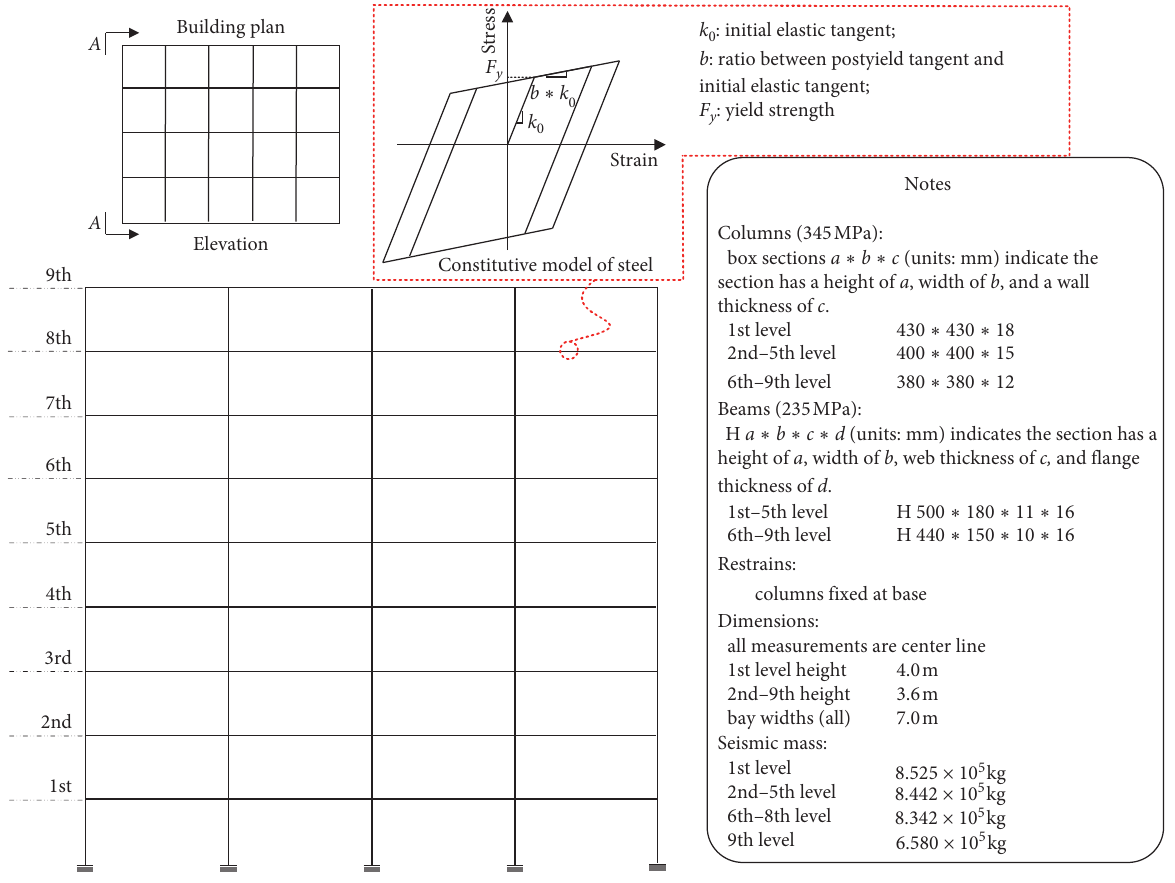
Figure 1: The 9-storey steel building benchmark model. Table 1: Periods of building benchmark model (unit: